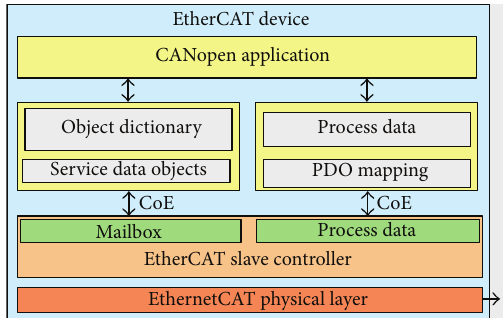
Figure 15: CANopen over EtherCAT device architecture (slide 128 of